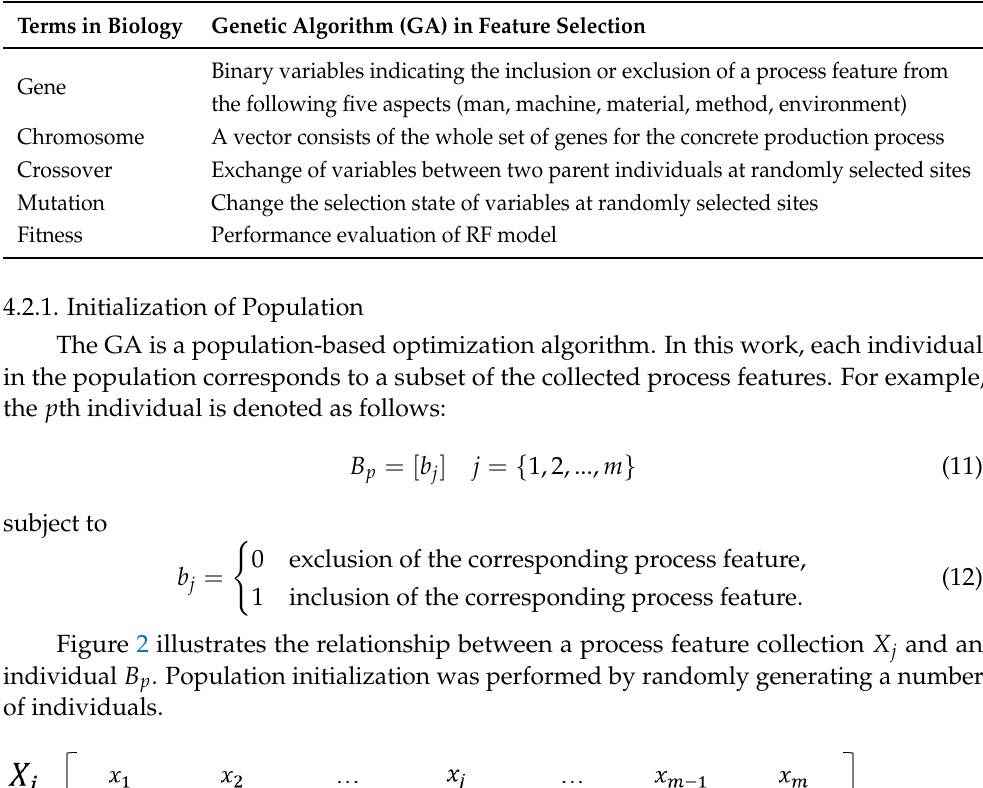
Table 3. Common terms in GA versus biology.